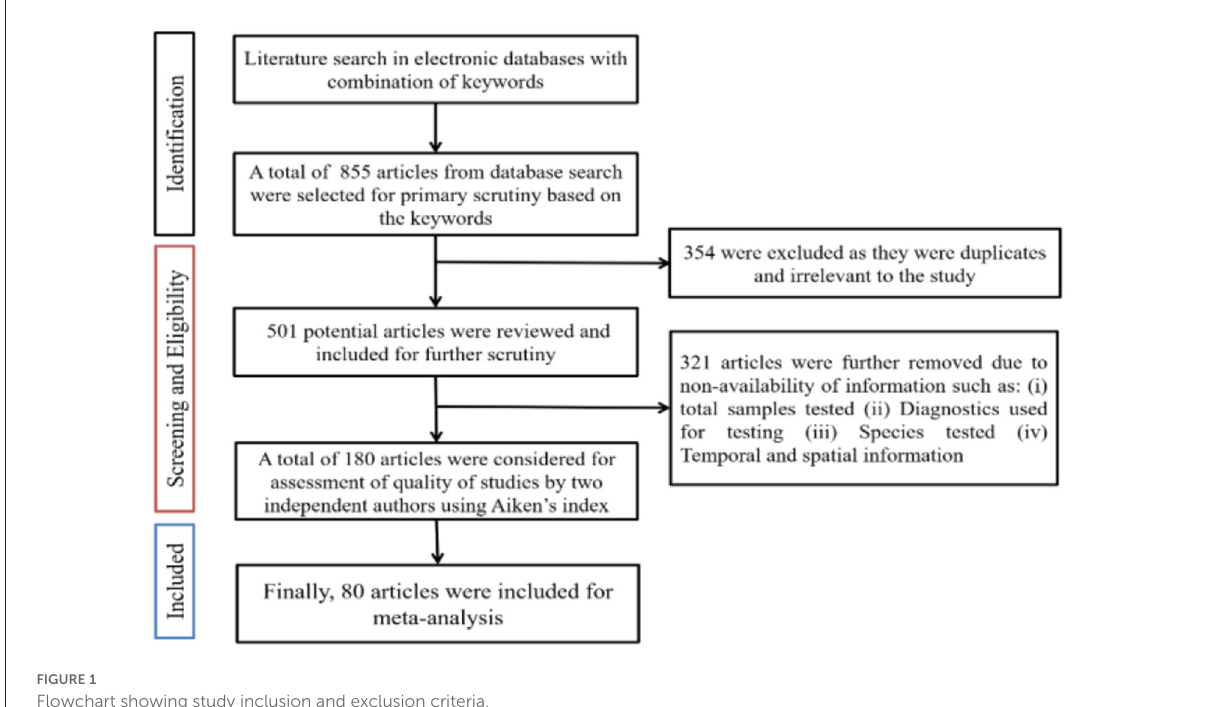
FIGURE1 Flowchart showing study inclusion and exclusion criteria.